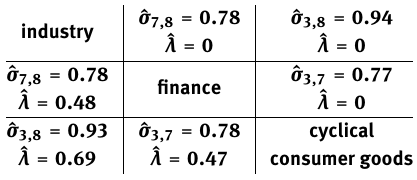
Table 2. Estimated coefficient of tail dependence (ˆ λ ) and entries of the dispersion matrix (ˆ σ i , j ) for Gaussian (upper triangle matrix) and t-copula (lower triangle